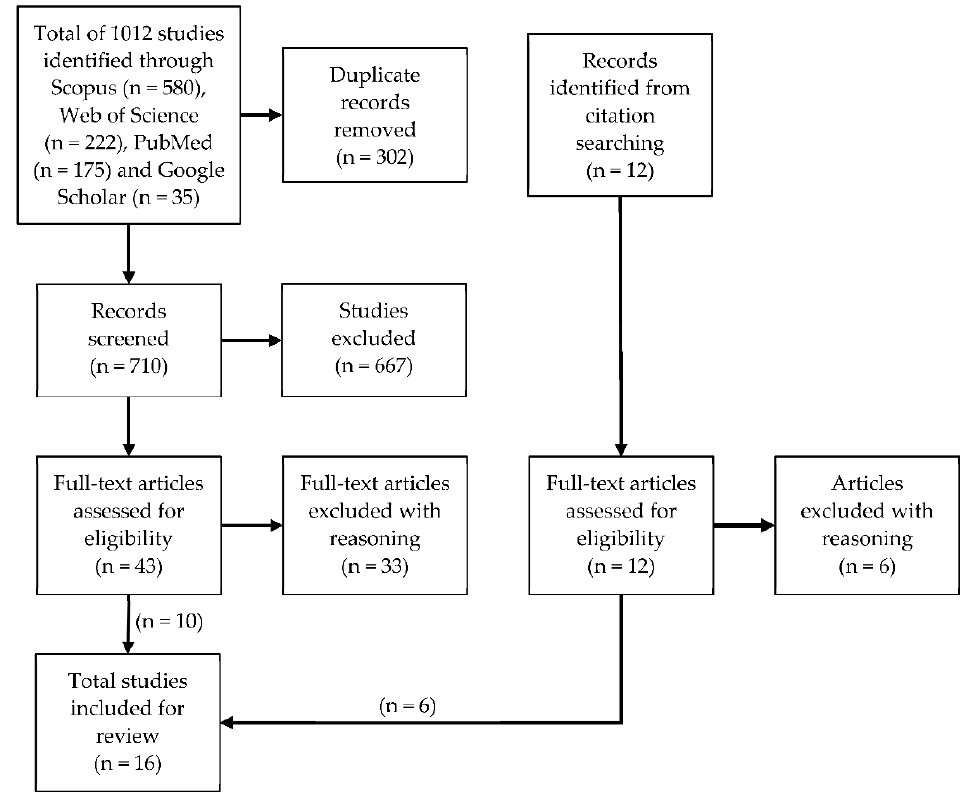
Figure 2. Literature search flow diagram presenting the exclusion process for studies showing the total number of articles (n = 16) identified as eligible.